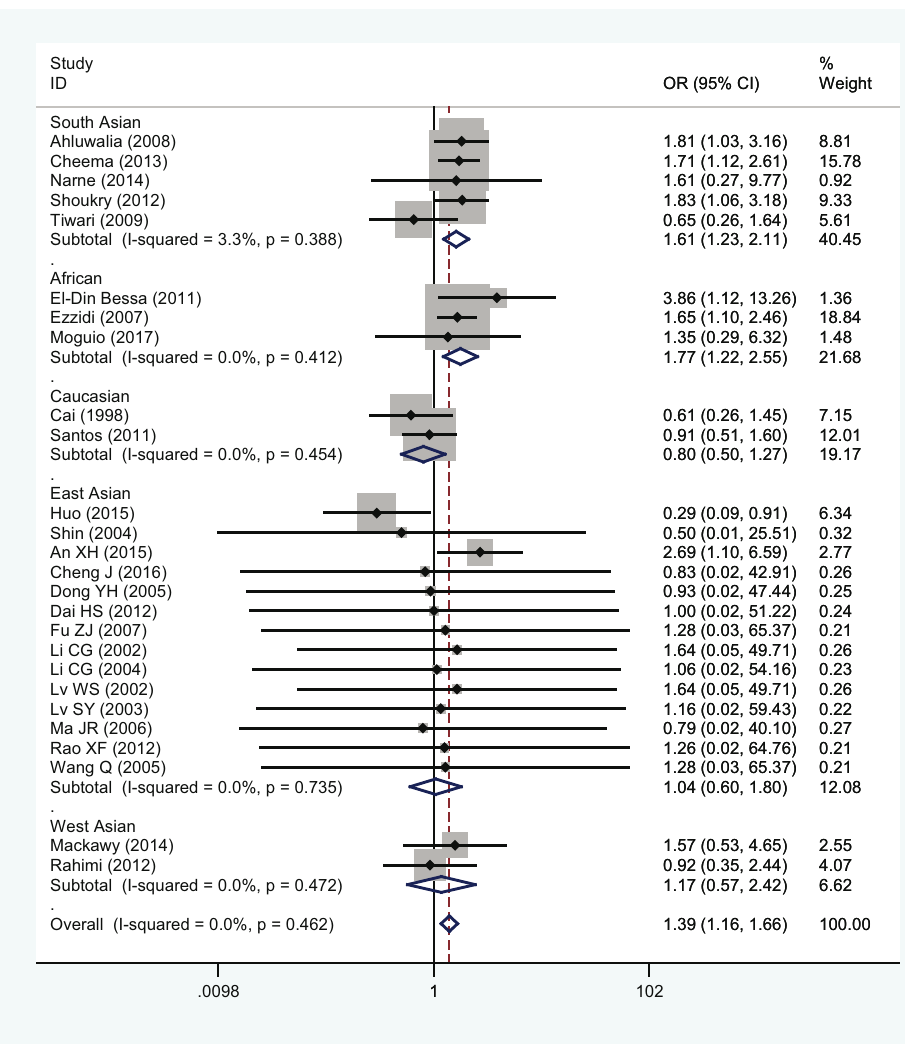
Figure 4: Forest plot of eNOS 894 G < T polymorphism and DN susceptibility in recessive gene model TT vs ( GT + GG )